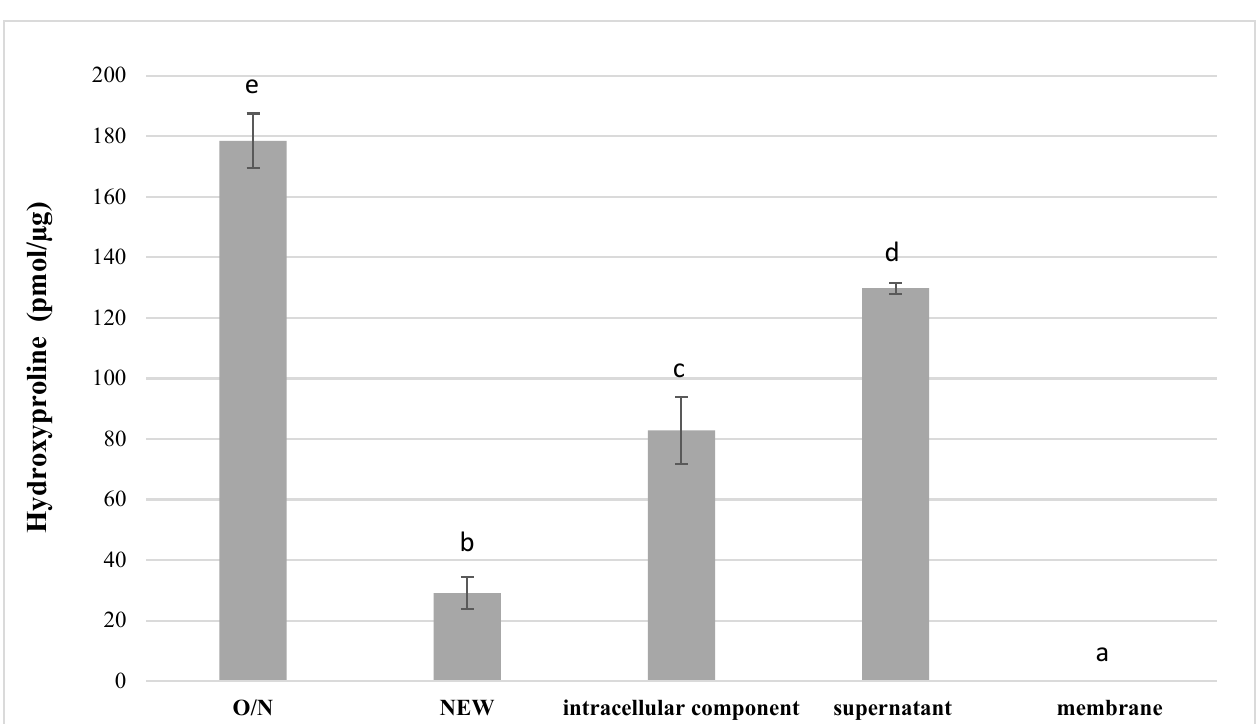
Figure 2. CLSM averaged images of autofluorescence of type I collagen gels incubated with ( A ) C. his- tolyticum collagenase (positive control), ( B ) PBS (negative control), ( C ) 1 / 4 THYE medium (negative control), ( D ) O/N S. mutans , ( E ) NEW S. mutans , ( F ) intracellular components, ( G ) supernatant and ( H ) bacterial membrane. The arrows point out structural changes (loss of collagen fibrils).